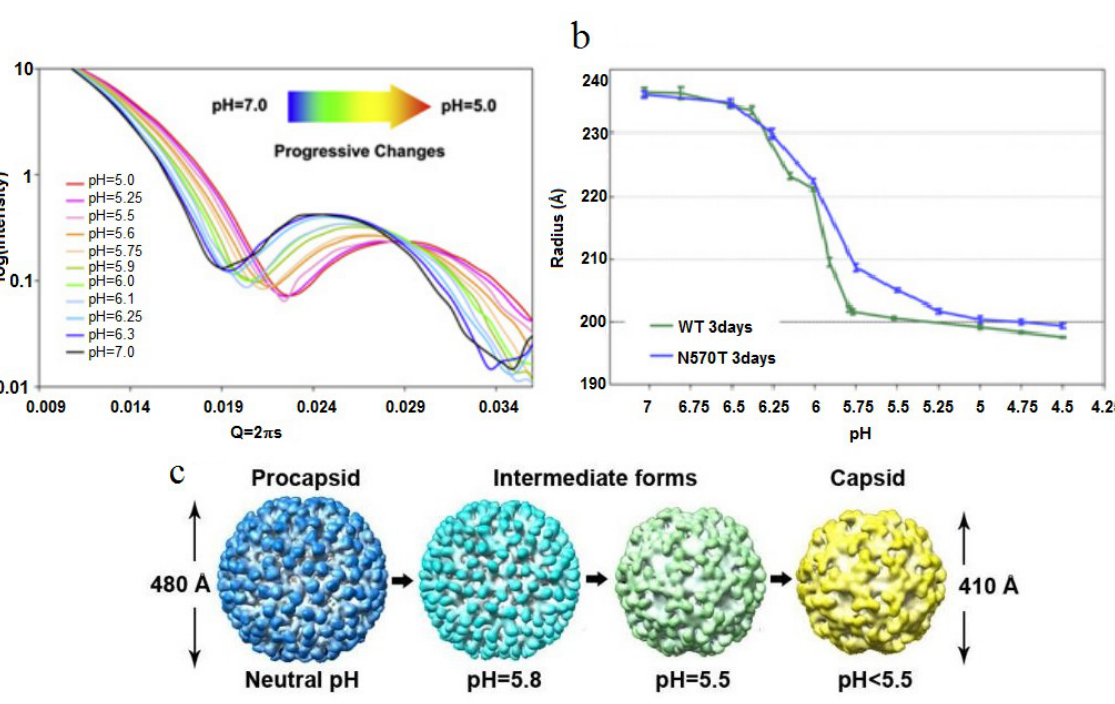
measurement of the particle diameter as a function of pH shows a smooth continuum of particle sizes as the pH is adjusted; ( b ) At pH 5, both the NT and WT capsid have the same radius of approximately 205-Å; ( c ) CryoEM densities of several maturation intermediates, showing the change in particle diameter as a function of pH. Reproduced with permission from Matsui et al .